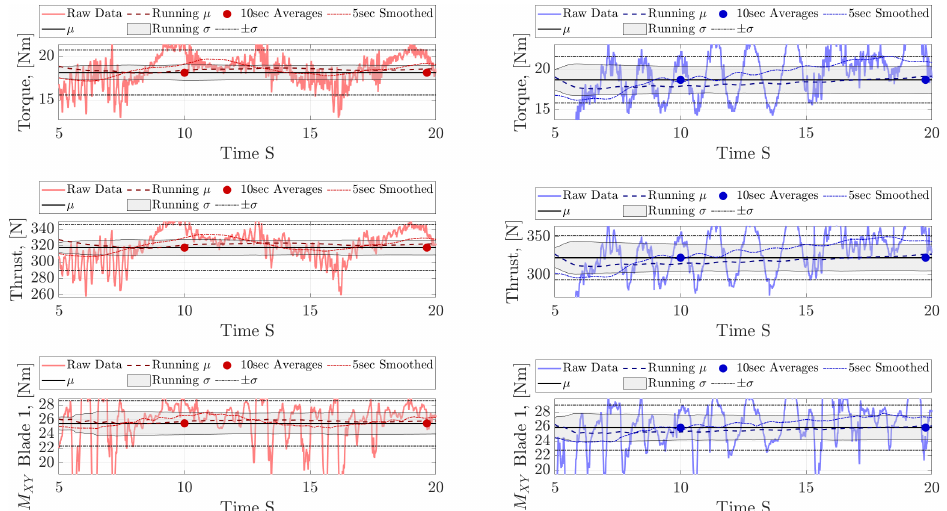
Figure 9. Example plots showing the rotor loading time series obtained for the rotor submerged to depth D3. The left plots show the CO cases and the right plots show the JSP cases. The top, middle and bottom plots show rotor torque, rotor thrust and blade 1 out-of-plane ( M XY ) blade root bending moments, respectively. The upper and lower bounds of the y-axis for each plot have been set to the 5th and 95th percentiles of the plotted datasets,